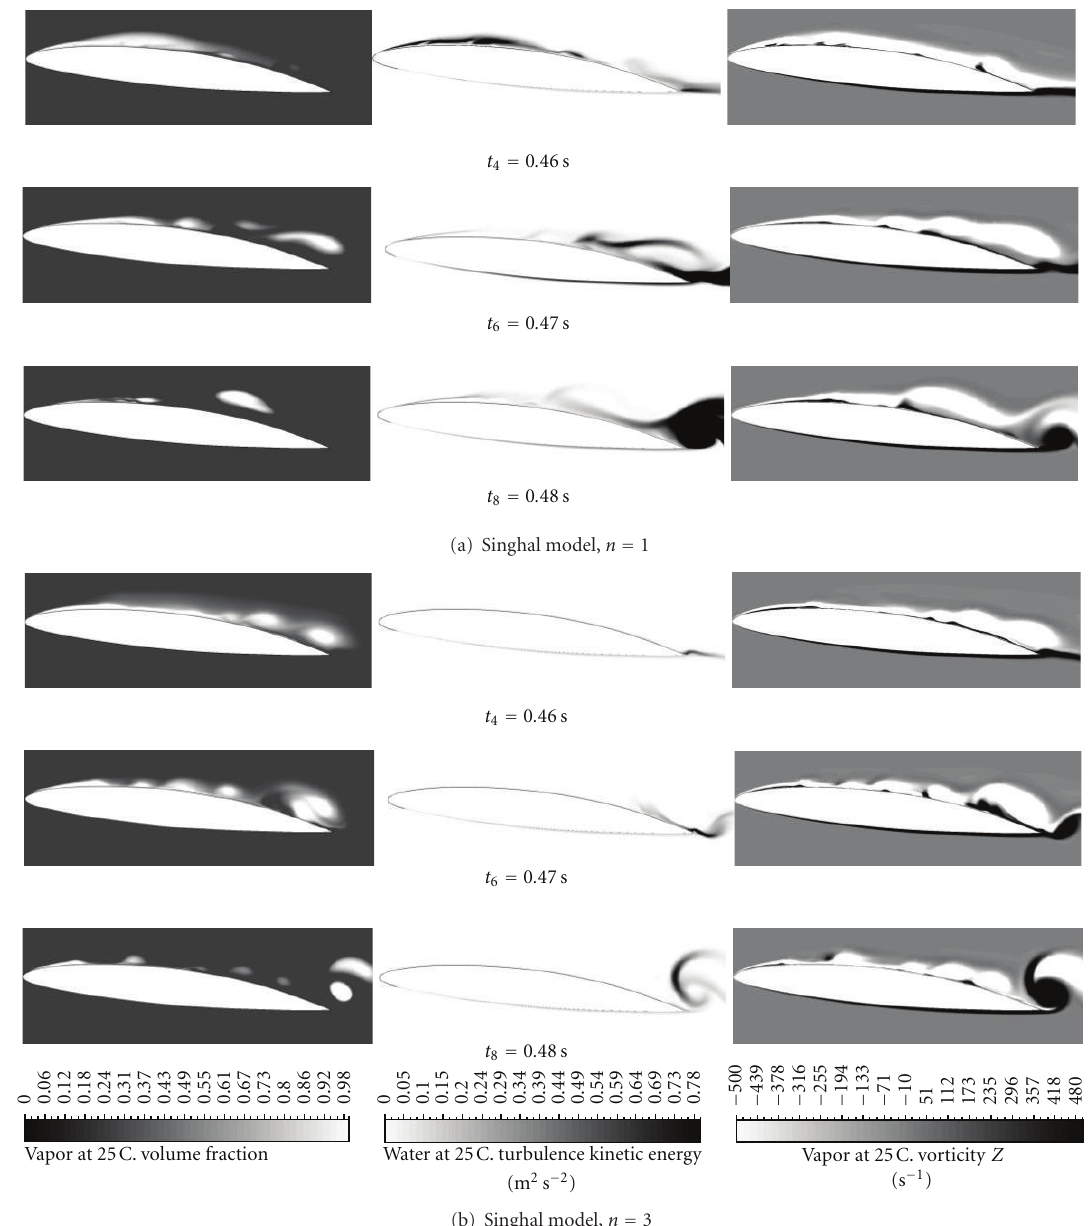
Figure 11: Comparison of the vapor fraction (left), turbulent kinetic energy (middle), and vorticity (right) contours for the Singhal cavitation models with (a) n = 1 and (b) n = 3, in the case of unsteady sheet/cloud cavitation with σ = 1 . 00, Re = 750,000, V ∞ = 5m/s, and α = 6 ◦